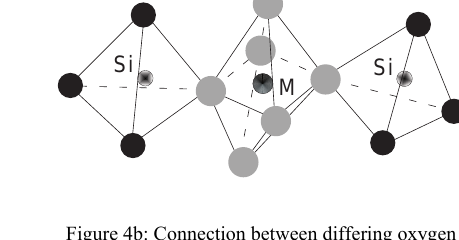
Figure 4b: Connection between differing oxygen coordination polyhedra through sharing of apical oxygens.